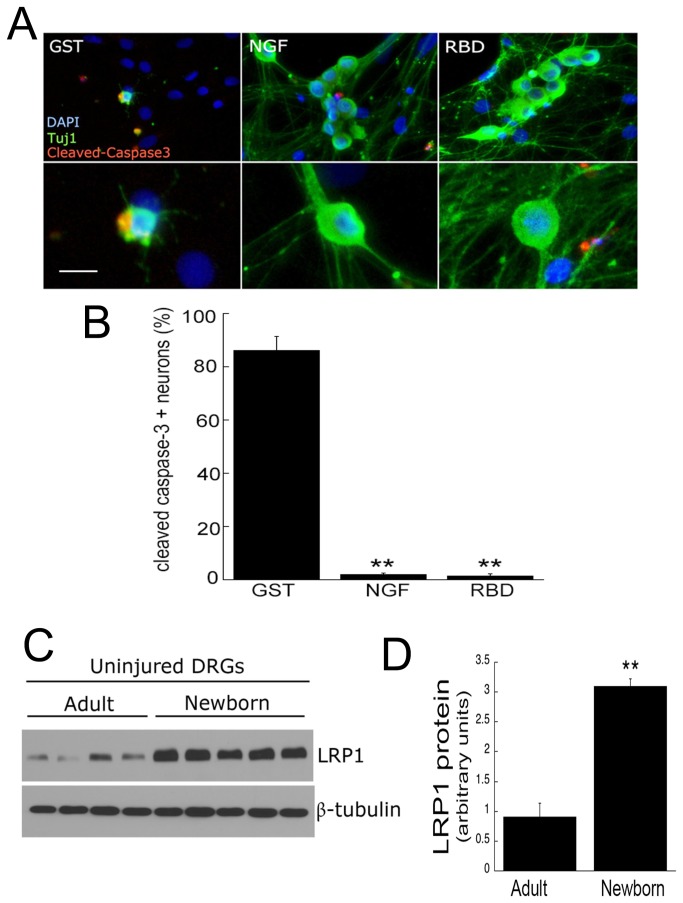
LRP1 promotes survival in primary embryonic sensory neurons and is abundantly expressed in neonatal dorsal root ganglia (DRGs).
A, Immunofluorescence microscopy of cleaved caspase-3 (red) and β-neuronal class III tubulin (Tuj1; green) in primary DRG neurons cultured for 2 weeks. Scale bar, 12 µm. Cell nuclei are identified by Dapi (blue). Images represent n=3 independent replicates. B, Quantification of cleaved caspase-3 positive neurons. Neurons in random fields within each treatment group were counted (n=3 independent experiments). C, Immunoblot analysis of LRP1 (85 kDa) in uninjured adult (8 weeks) or neonatal (1 day) rat DRGs. DRGs were solubilized in RIPA buffer supplemented with sodium orthovanadate and proteinase inhibitors. β tubulin was used as a loading control. Equal amounts of cellular protein (20 µg) were loaded into each lane and subjected to SDS-PAGE and electrotransferred to nitrocellulose for detection with specific antibodies. Each lane represents an individual rat. D, Quantification of LRP1 by densitometry. Data are expressed as mean ± SEM (n=5-7 rats), **p < 0.01 compared with respective GST.